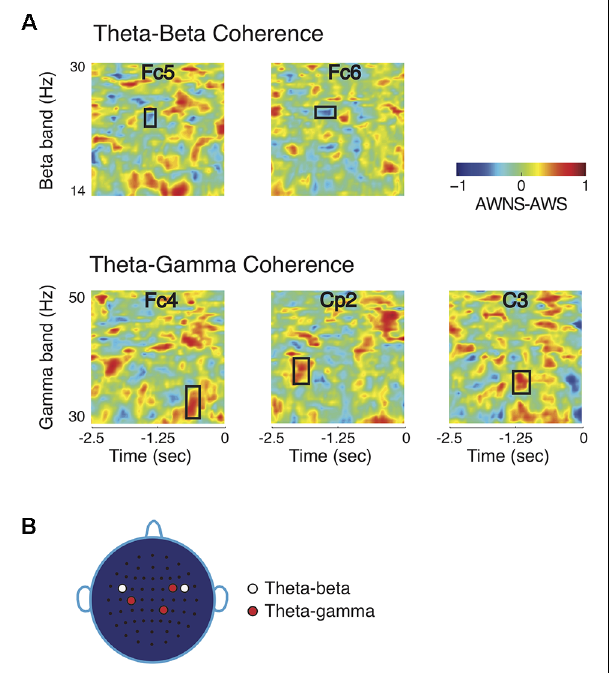
FIGURE 2 | Comparisons of coherence patterns between AWS and AWNS. (A) Phase coherence spectrograms are scaled from − 1 to 1. Only phase coherence involving theta band showed significant differences between the two groups. The ordinate of the spectrogram represents frequency range for the high-frequency beta and gamma bands, and the abscissa represent time, with 0 marking the appearance of the production prompt. Theta-beta coherence differences were observed at electrode locations Fc5 and Fc6 in time-frequency regions marked by rectangular windows, while theta-gamma differences were found at Fc4, C3 and Cp2. AWS had higher theta-beta coherence level, whereas AWNS had higher theta-gamma coherence. (B) Scalp electrode locations for which significant coherence differences between the two groups were observed. For theta-beta coherence, effects were observed at electrode locations Fc5 and Fc6 and for theta-gamma at Fc4, Cp2 and